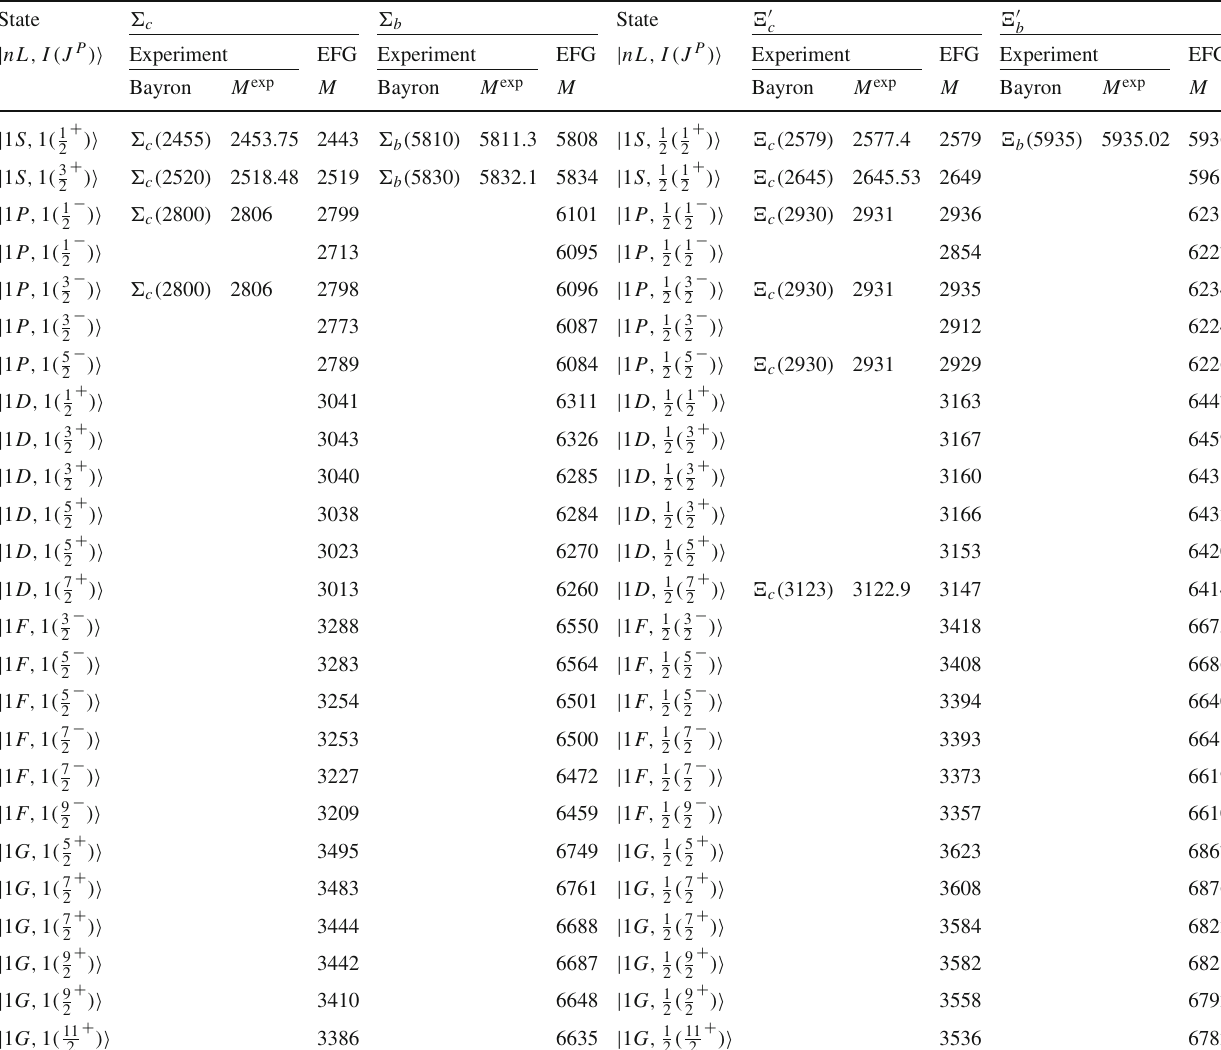
Table 4 The experimental [16] and EFG model values [18] for (cid:6) Q and (cid:7) (cid:3) masses [17] we adopted to analyze experimental data as well as EFG calculations are given by Eq.